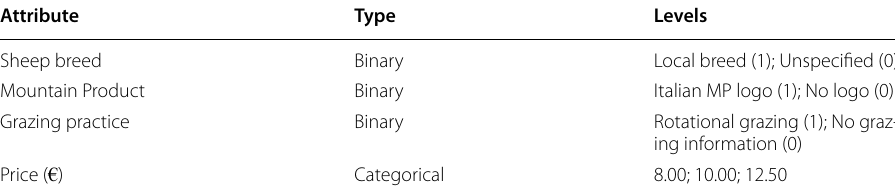
Table 1 Attributes used in the choice experiment Attribute Sheep